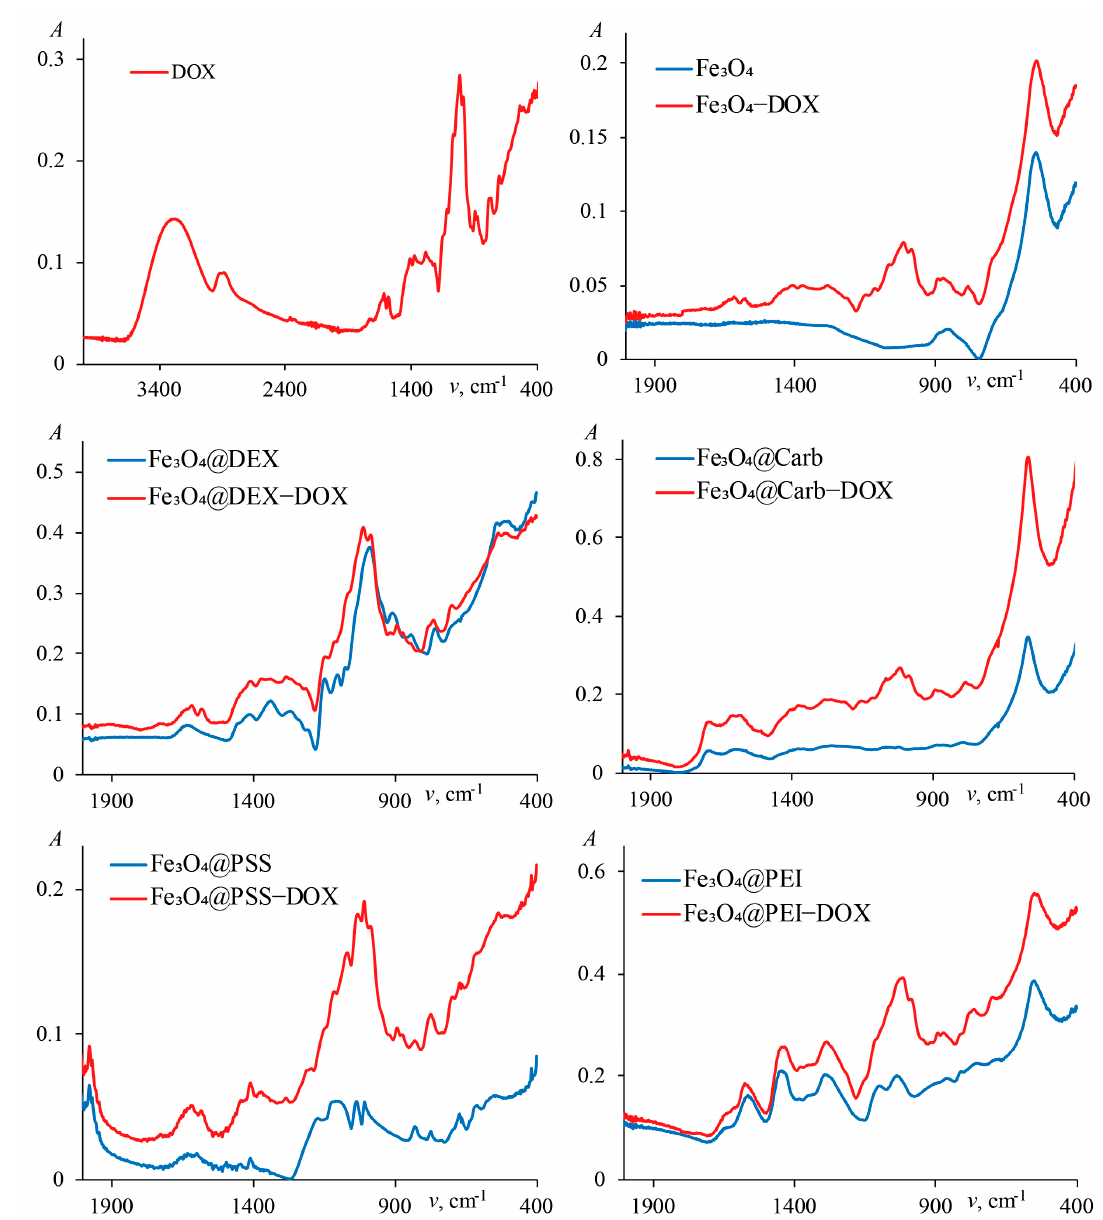
Figure 3. IR spectra of IONs covered by different surface modifiers with doxorubicin. Table 2. Characteristic IR bands of doxorubicin and its conjugates with magnetite nanoparticles.